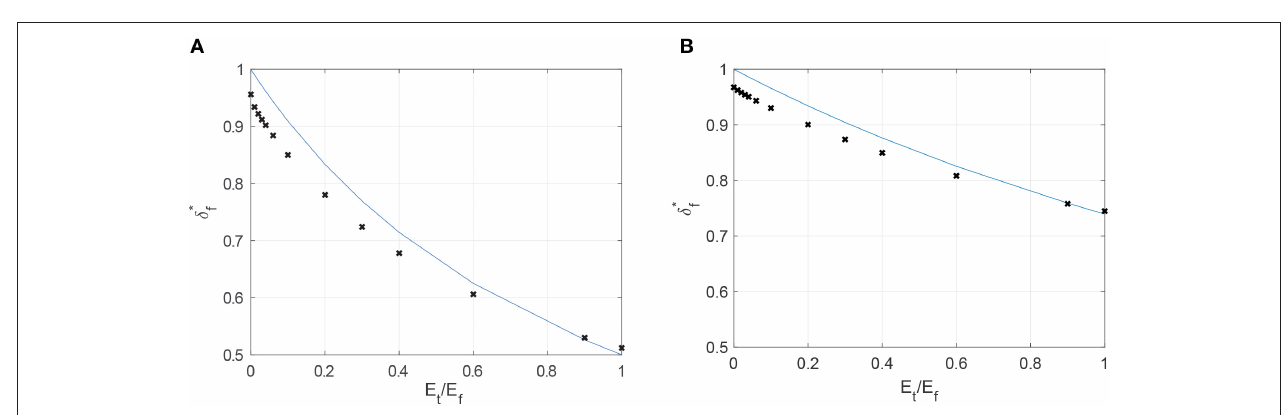
0.05). (A) Material set 1. (B) Material set 2. =